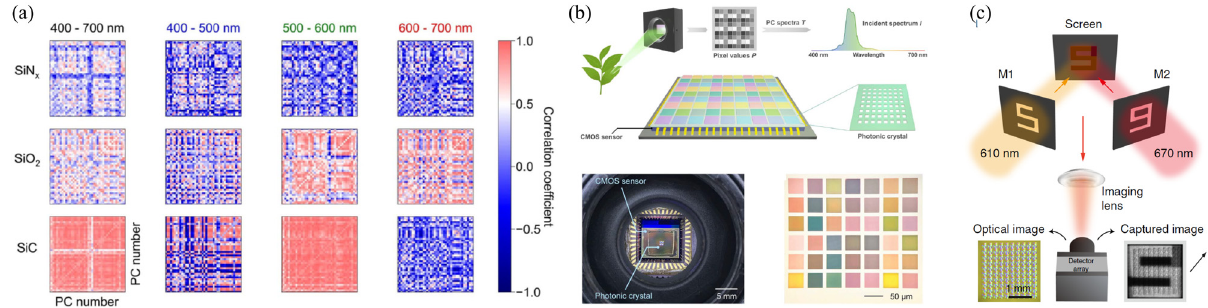
Figure 3: The correlation map between different nanophotonic filters and data acquisition set-up for spectral reconstruction and spectral imagingbasedonphotoniccrystalslabs.(a)Mappingofcorrelationcoefficientsbetweeneachpairofthe42simulatedtransmissionspectrain different wavelength ranges. Blue indicates weak or negative correlation; red indicates strong positive correlation. (b) Sensor operating principleandschematics(top).ThespectralsensorconsistsofanarrayofPCslabsatopaCMOSimagesensor.Thetransmissionspectraofthe PCslabsdiffersignificantlyfromeachotherandformasamplingbasis,T.Foranincidentlight,thepixelvaluesofthesensorandthesampling basis T are used to infer the unknown spectrum of the light. Device photograph (bottom) of an array of PC slabs fabricated on a SiN x /quartz substrate and placed on a CMOS image sensor. (c) Hyperspectral imaging using the PC spectrometer. The imaging target is a mix of the numbers “ 5 ” and “ 9 ” , with the “ 5 ” comprising light incident on the screen at 610 ± 5 nm and the “ 9 ” comprising light at 670 ± 0.7 nm. The spectral information of this target is obtained via a single snapshot. The optical and captured images are shown on the left and right of the device, respectively. (a) and (b) are reprinted with permission from Ref. [23], copyright 2019 Optical Society of America; (c) is reprinted with permission from Ref. [22], copyright 2019 Nature Publishing